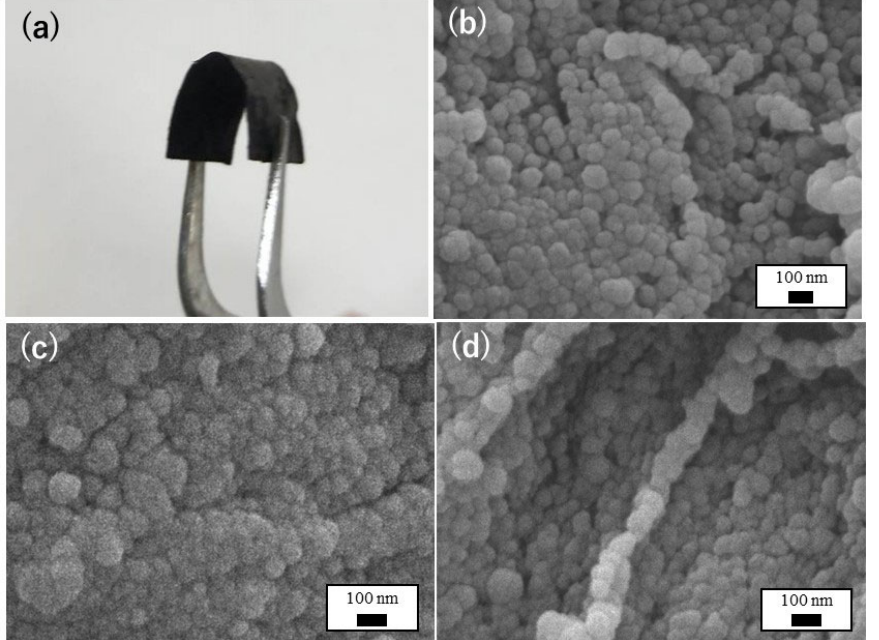
Figure 4. ( a ) An image of a bent Cdots/PPy/Fe 3 O 4 /TOCNF composite film. The FESEM images of Cdots/PPy/Fe 3 O 4 /TOCNF composite film ( b ) in a pristine state, ( c ) after bending 50 times and ( d ) after electrochemical measurement.